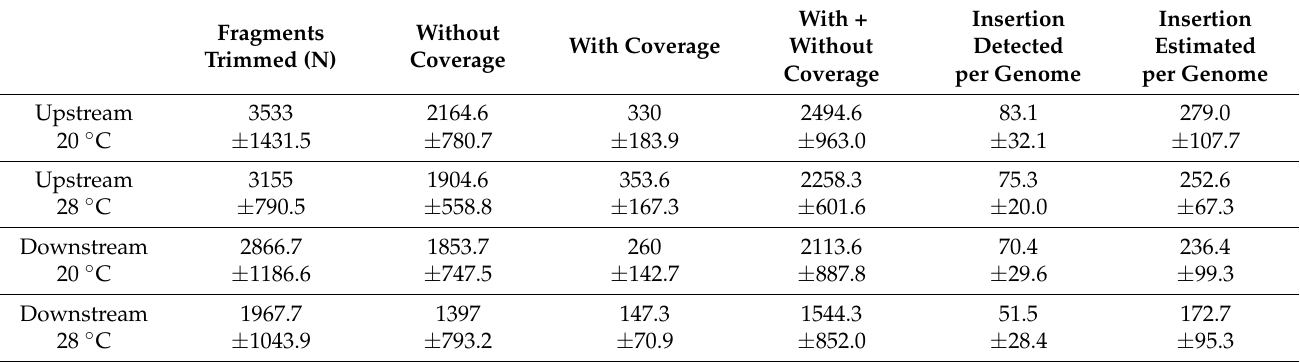
Table 1. Somatic insertion values per genome and estimate for 100% of the genome. The means and standard deviations for each of the treatments and ends are represented according to the type of fragment and